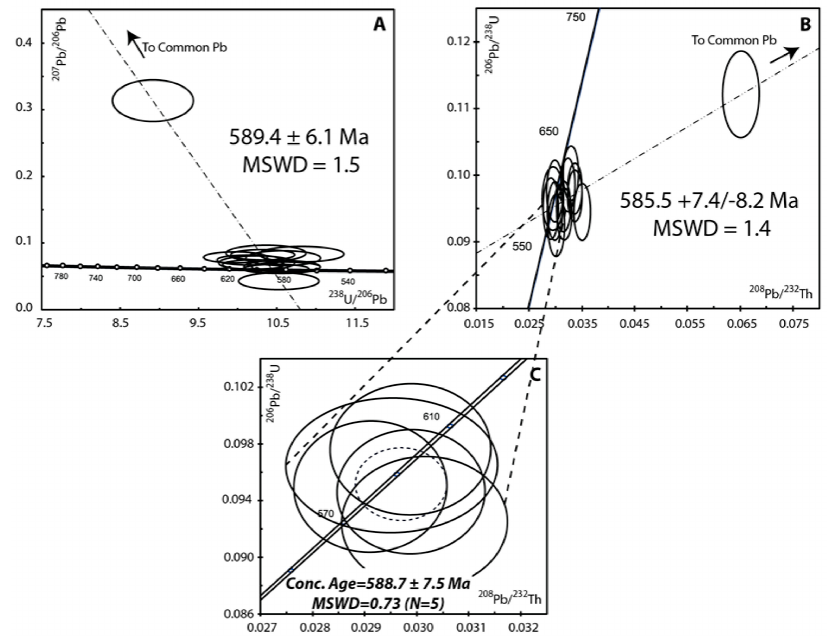
Figure 13. Tera–Wasserburg ( A ) and 206 Pb/ 238 U versus 208 Pb/ 232 Th ( B , C ) Concordia diagrams for monazite from Gakara. Error ellipses and age calculations are reported with 2 σ